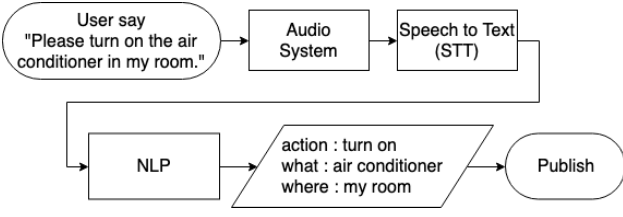
Figure 8. The flowchart of user’s voice semantic analysis.